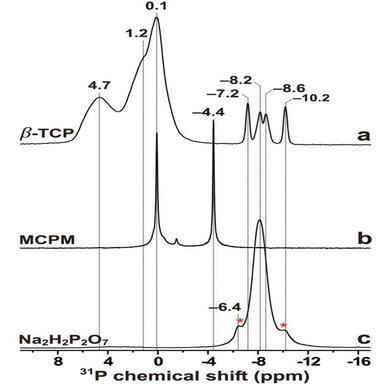
31P NMR spectra obtained at 14.00 kHz MAS from the following cement precursors: (a) β–Ca3(PO4)2 (β–TCP), comprising 9.1 wt% β-Ca2P2O7 that produces the signals at P= ppm; (b) Ca(H2PO4)2·H2O (MCPM); (c) Na2H2P2O7; the 31P NMR peaks at δP = ppm (marked by asterisks) are associated with the PyroX phase discussed in sections and S1 of the Supplementary Material.